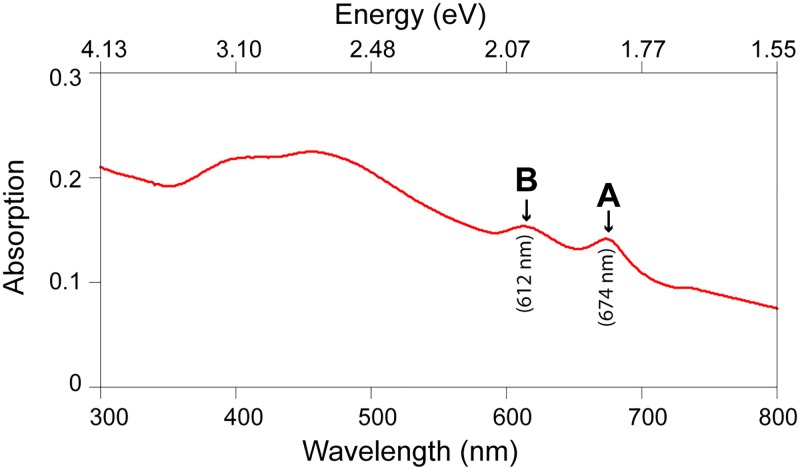
UV-Vis absorption spectrum for MoS2 dispersion in water.